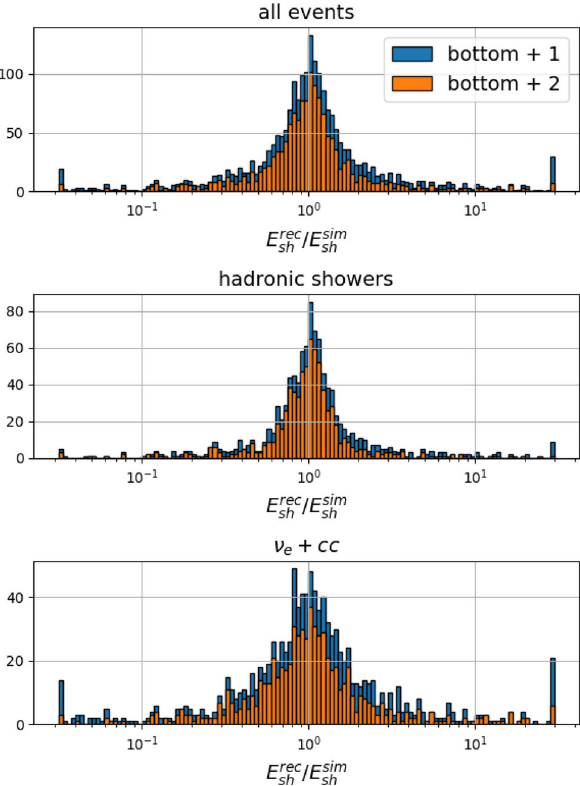
Fig. 19 Ratio between reconstructed and actual shower energy if the indexofrefractionmodelsusedforsimulationandreconstructiondiffer. Shownareresultsofeventswhereatleastoneofthechannelsat ∼ 100m aswellasatleastone(blue)oratleasttwo(orange)oftheotherchannels on the power string detected a signal with SNR ≥ 2 . 5. The outermost bins are overflow